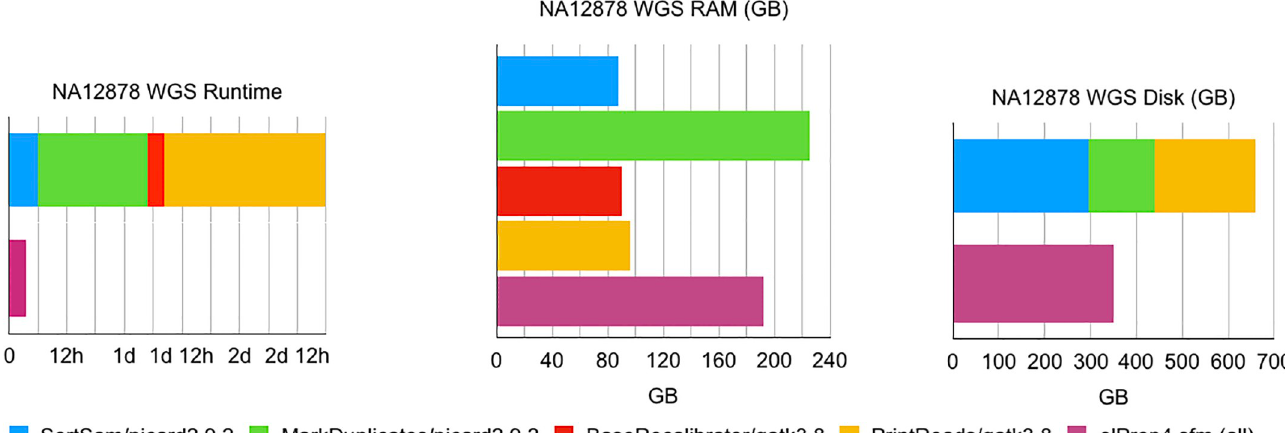
Fig 3. WGS benchmarks. Runtime, RAM use, and disk use in GATK 3.8 vs. elPrep 4 (sfm mode). elPrep 4 executes the pipeline 18.2x faster than GATK 3.8, using 0.85x of the RAM, and only 0.8x of the disk